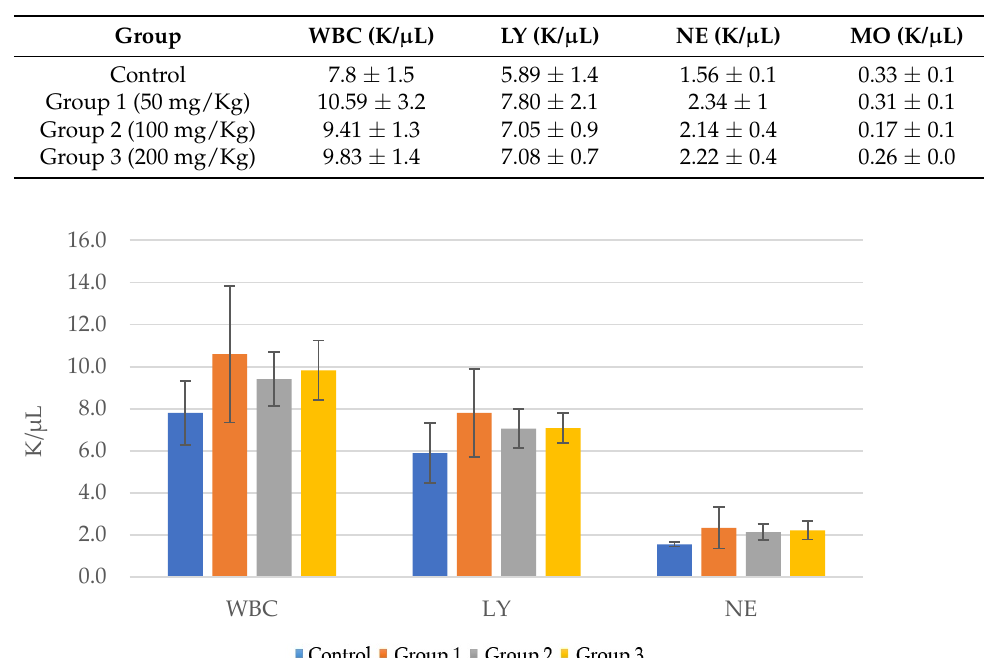
Table 11. The effect of administering ImunoBoost in three different concentrations on the lymphocyte populations and their subpopulations in mice.